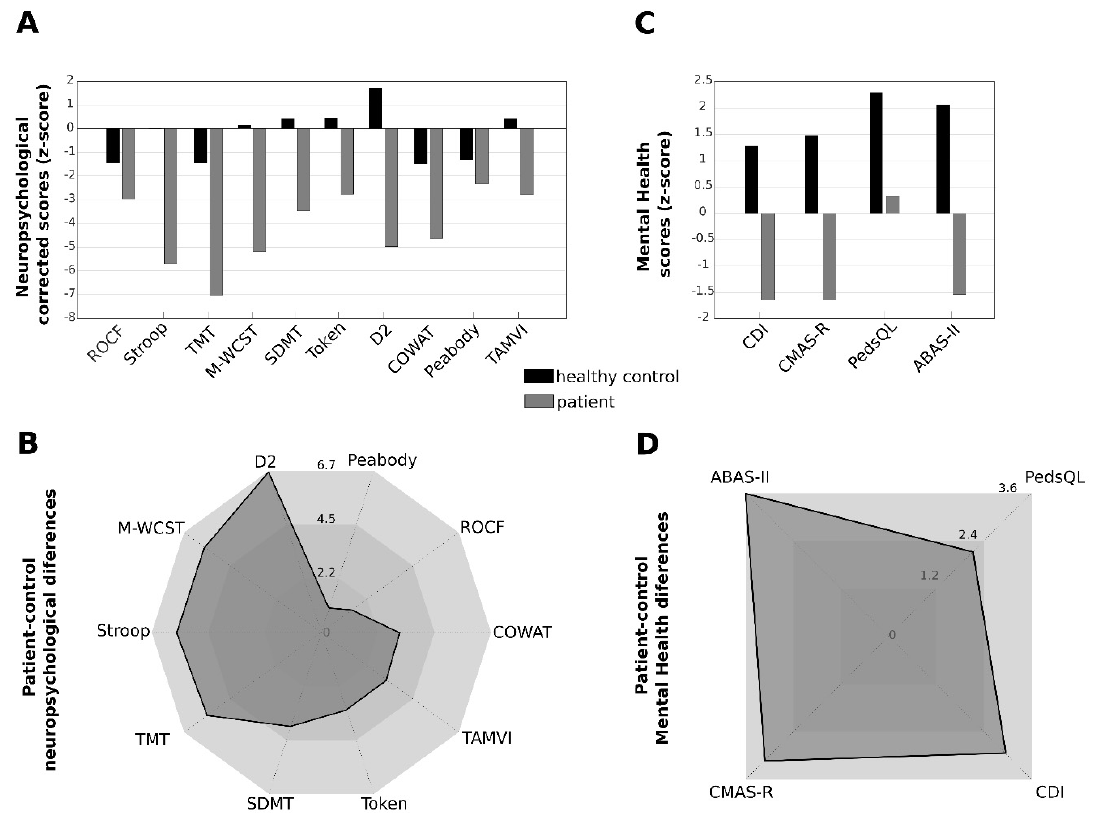
Figure 5. Neuropsychological and psychosocial alterations in combined Cobalamin D disorder: ( A ) corrected Z-scores for both patient (grey) and control (black) of ten di ff erent neuropsychological tests measuring di ff erent neuropsychological functions: Rey–Osterrieth Complex Figure Test (ROCF; visuoconstructive skill; memory), The Stroop Color and Word Test (Stroop; attention and inhibitory control), Trail Making Test (TMT; attention and mental flexibility), Modified Wisconsin Card Sorting Test (M-WCST; executive function), Symbol Digit Modalities Test (SDMT; processing speed), Shortened Version of the Token Test (Token; receptive language), D2 Test of Attention (D2; attention), Controlled Oral Word Association Test (COWAT; language and executive function), Peabody Picture di ff erences for each of the ten di ff erent neuropsychological scores; ( C ) and ( D ) evaluation results and patient-control di ff erences for tests assessing mental health, quality of life, and adaptive behavior: Children Depression Inventory (CDI; depression), Revised Children’s Manifest Anxiety Scale